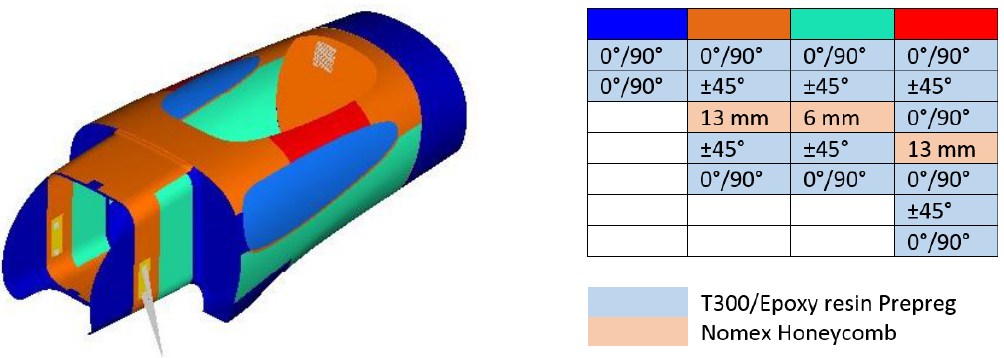
Figure 9. Free-size-optimization of honeycomb thickness: Top ( left ) and bottom ( right ) view.